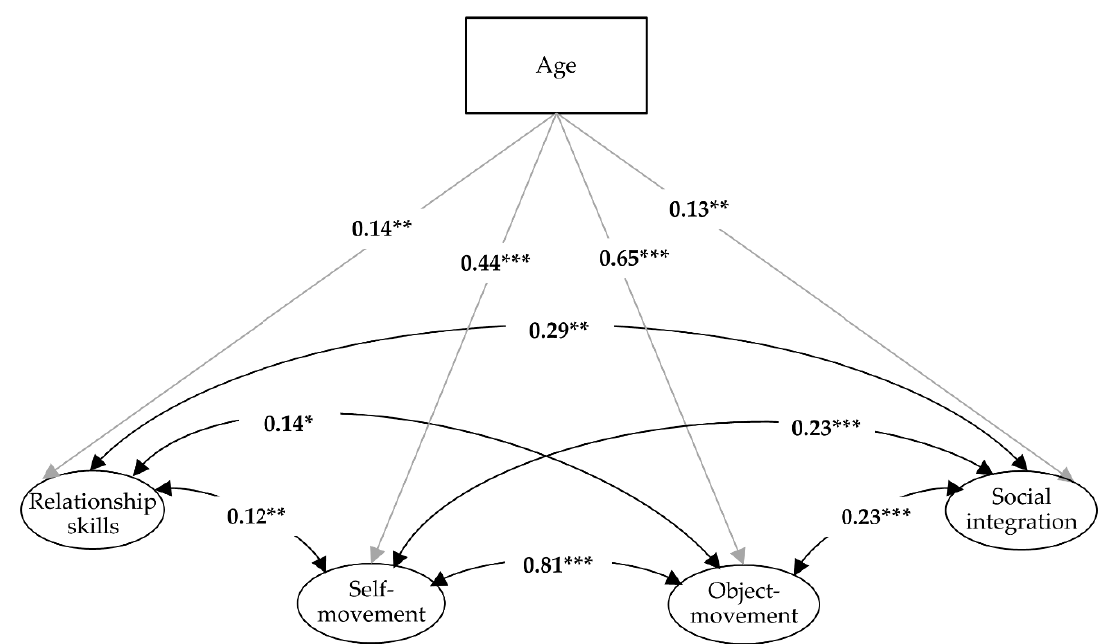
Figure 1. Four-factor confirmatory analyses with the covariate age (Model 2: * p ≤ 0.05, ** p ≤ 0.01, and *** p < 0.001). Table 3. Intercorrelations between the latent factors and with age as a covariate (model 3).